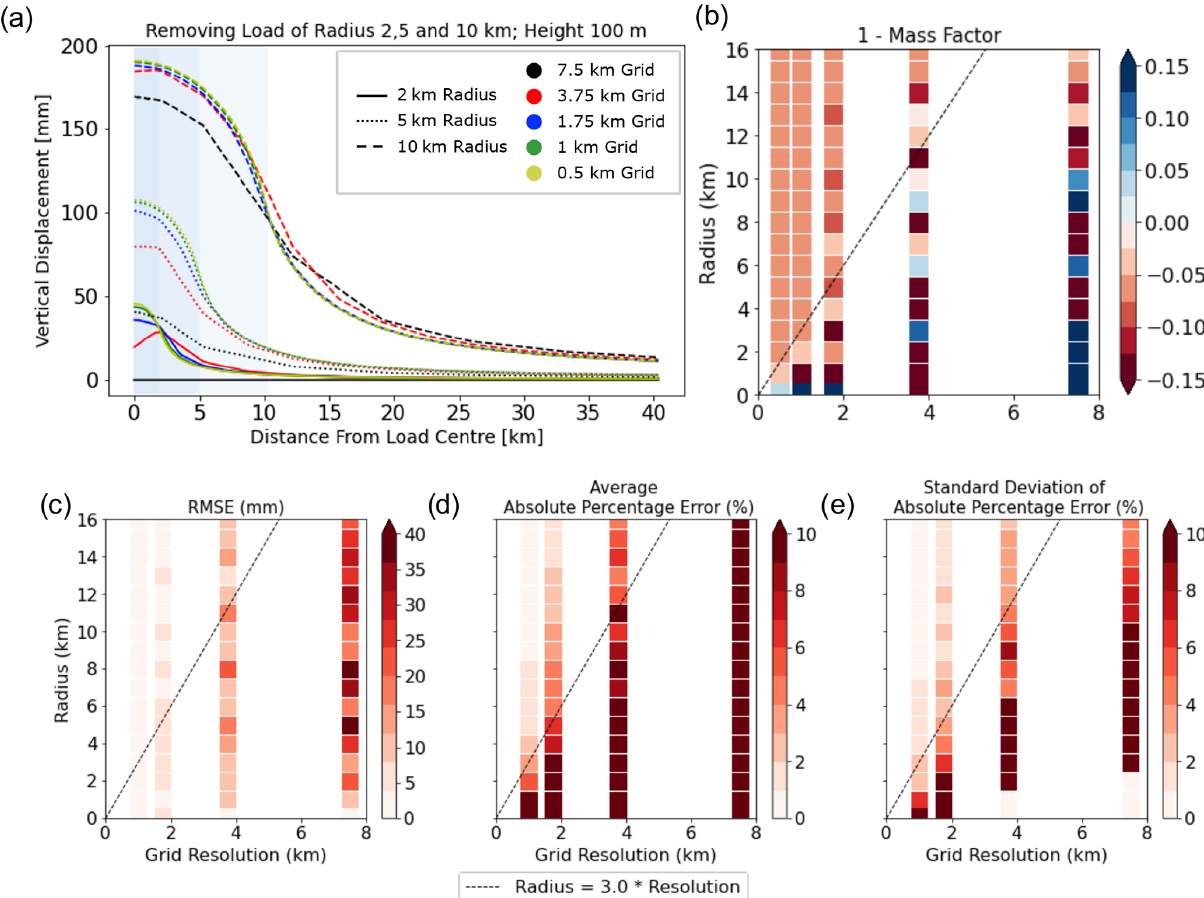
Figure 3. Idealised sensitivity experiment of the effect of surface grid resolution on GIA model calculations with elastic bedrock deformation due to instantaneous removal of cylindrical ice loads. Cylinders are all of unit height 100m and radius from 0.5 to 16km. Five grid resolutions applied within an area of minimum 40km width were tested: 0.5, 1, 1.75, 3.75 and 7.5km (Fig. S1). (a) Transect of bedrock deformation for removal of ice cylinders with unit height and radii of 2km (solid lines), 5km (dotted) and 10km (dashed lines). (b) Results of a suite of simulations adopting ranges of ice cylinder radii and grid resolutions. (b) Colours indicate 1 minus the mass factor (1 − mass factor), in which the mass factor is the ratio of the theoretical mass of the load and the mass of the load represented on the given model grid; 0 represents a scenario in which the model grid perfectly represents the mass of the idealised load, whilst positive (blue) and negative (red) values indicate the load mass is over- and under-represented by model grid resolution, respectively. (c) Root mean square error across the suite of simulations (mm). (d) Average absolute percentage error (%). (e) Standard deviation of the absolute percentage error (%) of the given test from the finest 0.5km resolution model result. Errors displayed on (c–e) are calculated within 2km of the loaded region. Dashed black lines represent the 1 : 3 ratio between the surface grid resolution and idealised load cylinder radius, whereby average absolute percentage error becomes < 7 ± 3( σ )% for all scenarios. In panels (b–e) the colour bars are saturated according to the arrows on the respective colour